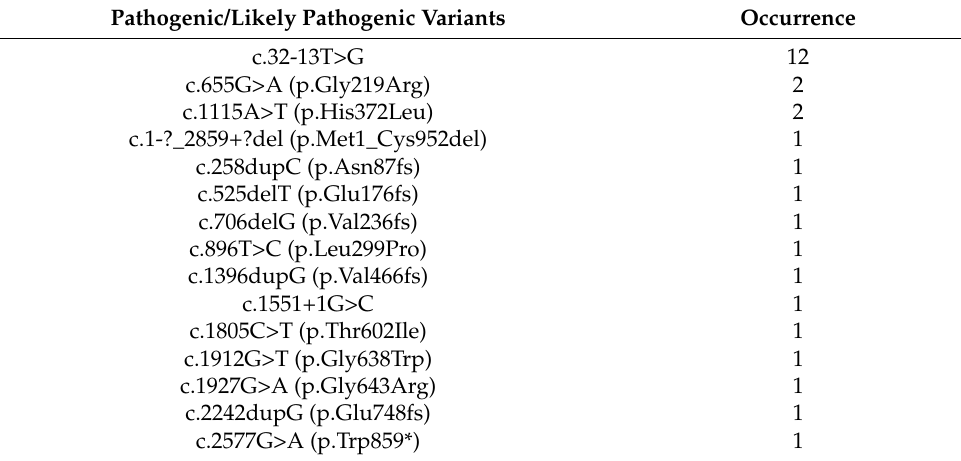
Table 1. Pathogenic and likely pathogenic variants found in the GAA gene in patients with Pompe disease. All variants were observed only in the compound heterozygous state. Occurrence denotes the number of times each variant was observed in this group (14 patients; 28